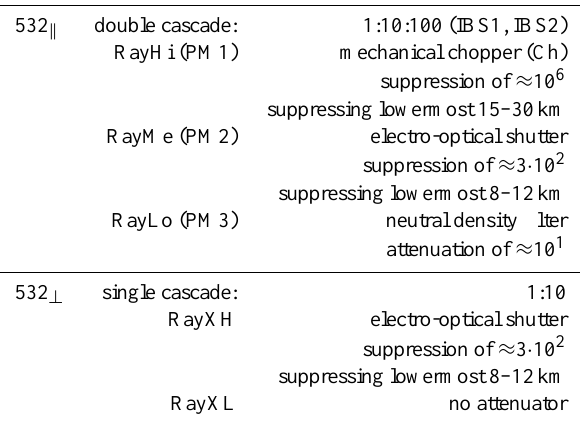
Fig. 3. RayXH and RayXL refer to the high and low sensitive chan- nel in perpendicular